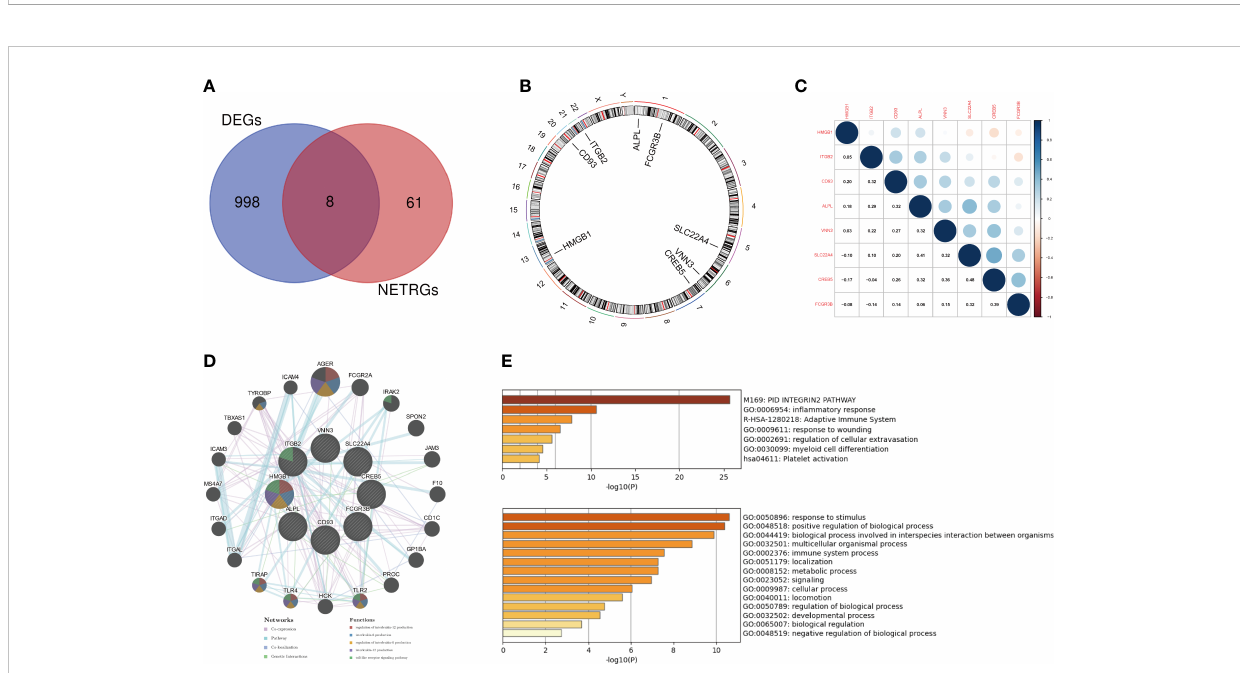
FIGURE 4 Gene expression patterns and PPI network of DE-NRGs. (A) The overlap of genes between DEGs and NRGs. (B) The location of the DE-NRGs on chromosomes. (C) Correlation matrix of DE-NRGs. (D) PPI network of DE-NRGs and its interacting proteins. (E) GO enrichment analysis of interacting proteins of DE-NRGs. PPI, protein-protein interaction; DEGs, differentially expressed genes; NRGs, NETs-related genes; GO, gene